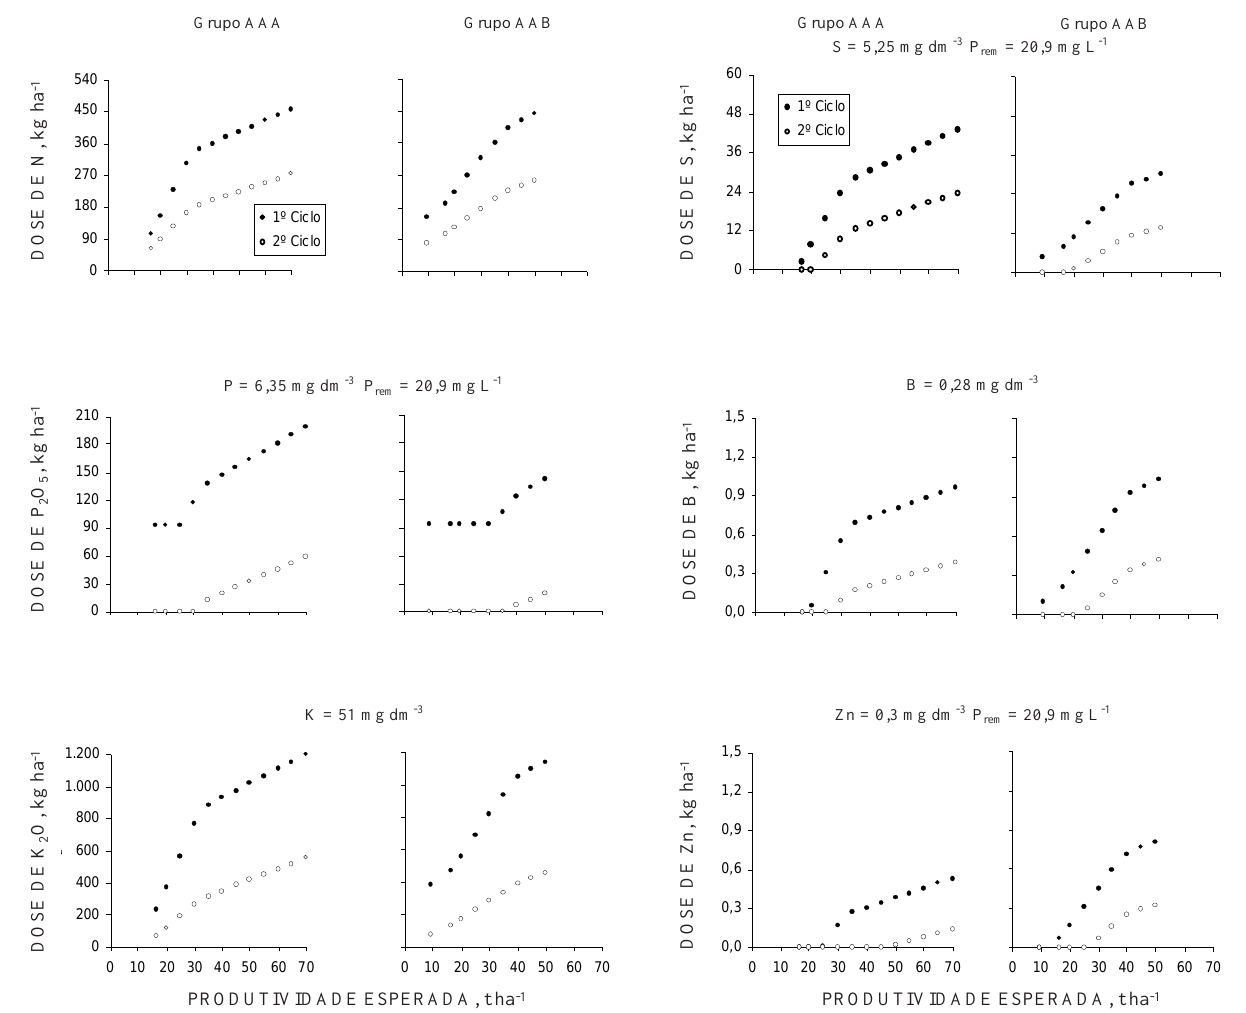
Figura 5. Doses de enxofre, boro e zinco recomen- dadas pelo FERTICALC (cid:210)(cid:210)(cid:210)(cid:210)(cid:210) -Bananeira em função da produtividade esperada, para bananeiras dos grupos AAA e AAB, no primeiro e no se- gundo ciclo.